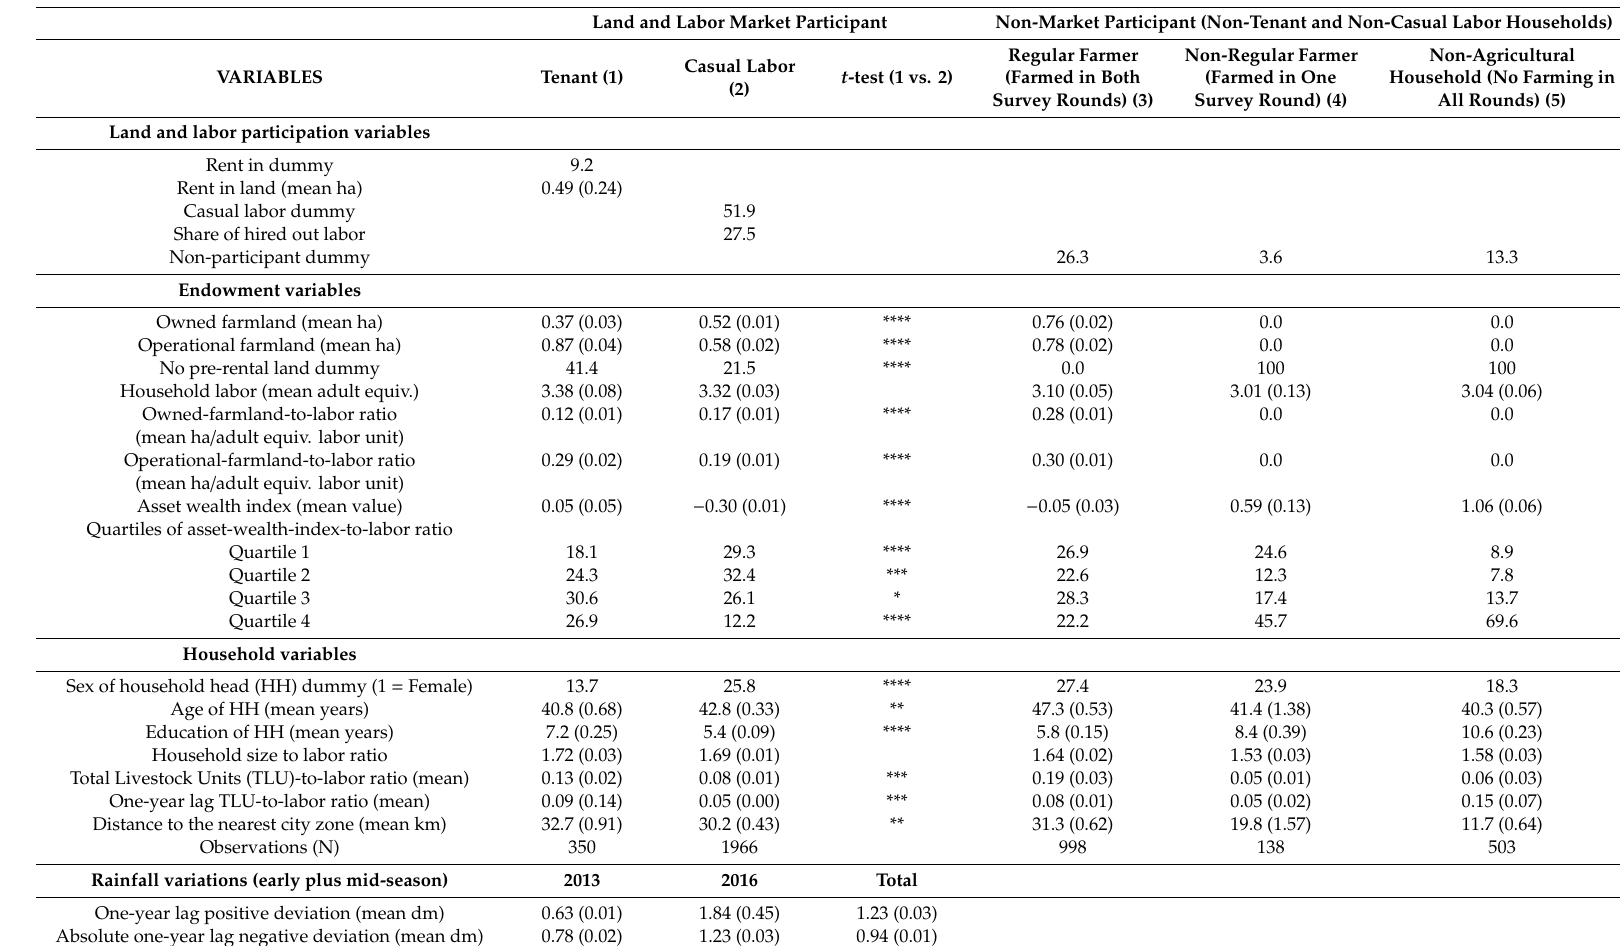
Table 2. Statistical